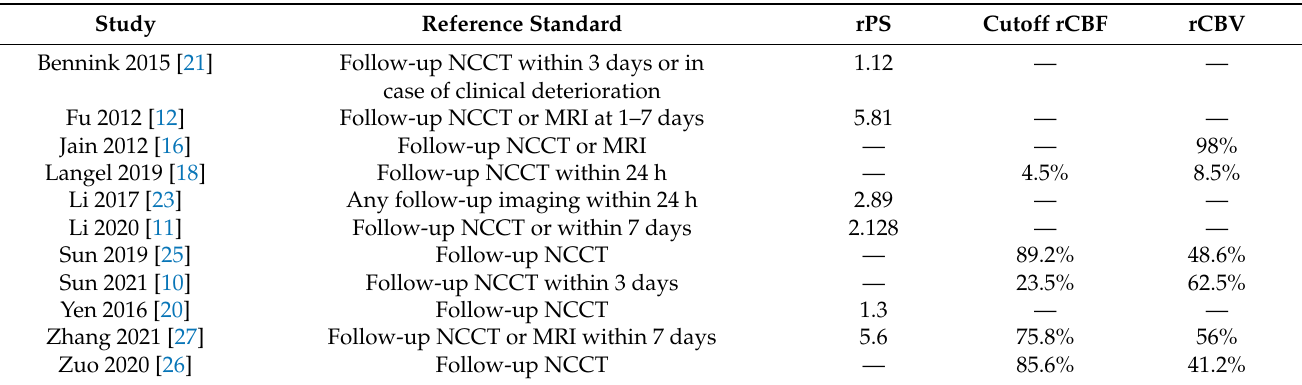
Table 3. Characteristics of included studies which provided diagnostic performance of rPS, rCBF, or